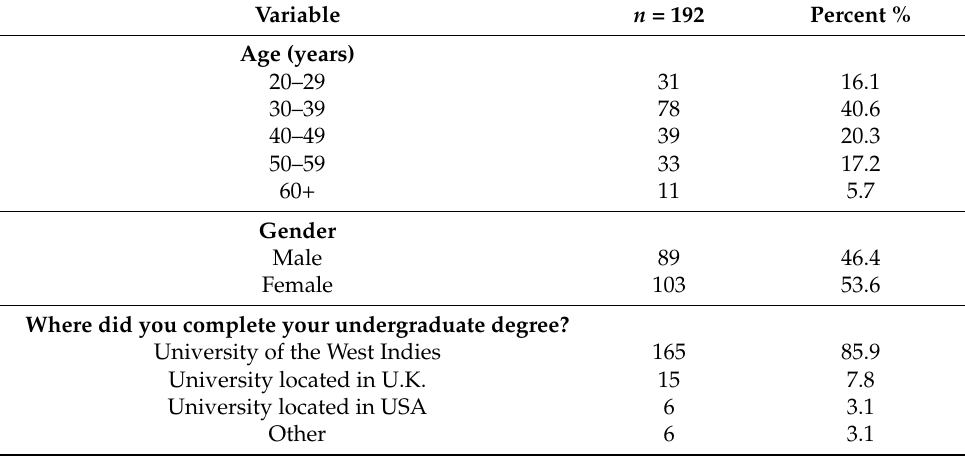
Table 1. Demographics of